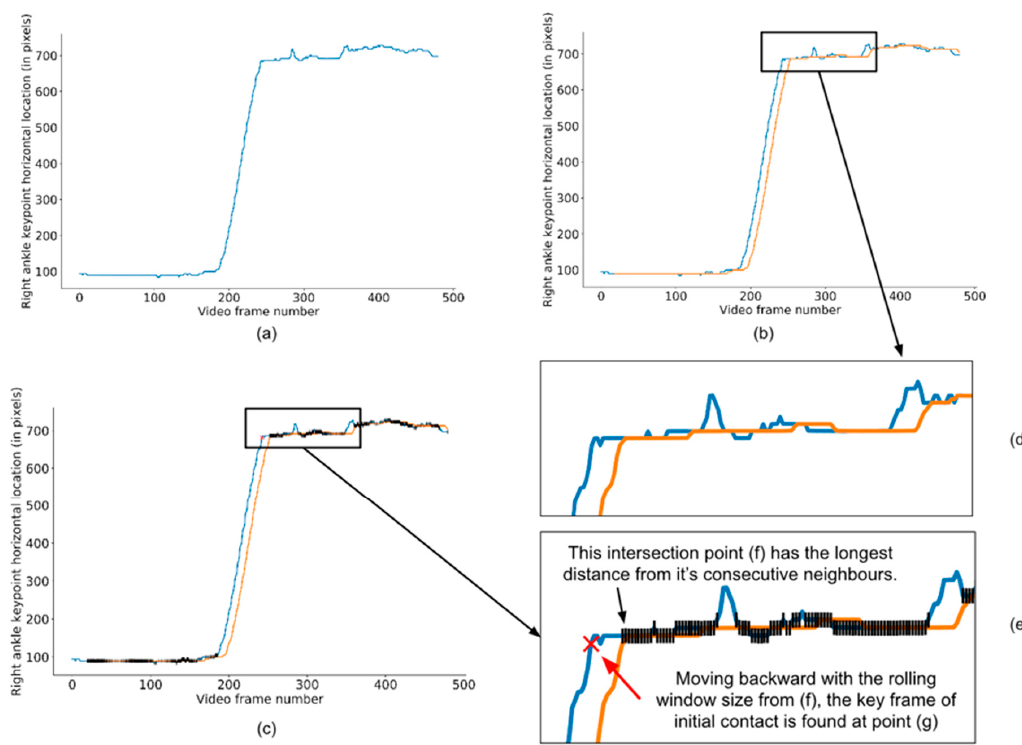
Figure 2. This figure is an example of the original (blue line) plot and rolling window (orange line) plot for the right ankle keypoint of one individual during a drop-jump landing trial taken from the lateral view video. More specifically, ( a ) the blue line depicts the distance of the right ankle to the left boarder (y-axis) in each video frame (x-axis); ( b ) the orange line is the 20-frame rolling median of the original blue line; ( c ) the black bars indicate the intersections of the two lines, whereas the red dotted line represents the distance between two consecutive intersection points. Figure ( d ) is a zoomed-in view of the intersections around the initial contact key frame. Figure ( e ) highlights the points (f) and (g) as the initial contact key frame on the rolling window plot and original plot, respectively.